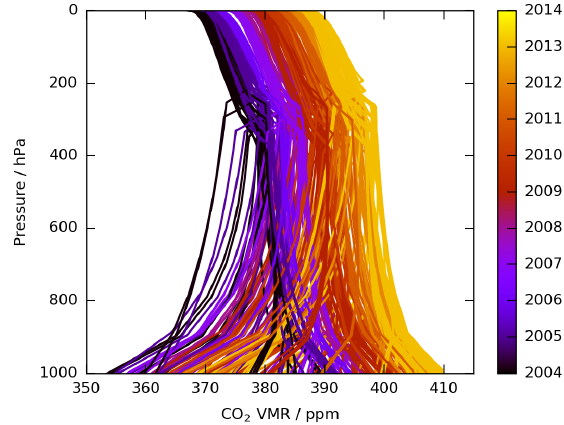
Figure 2. The TCCON a priori profiles calculated for Ny-Ålesund and the time frame of this